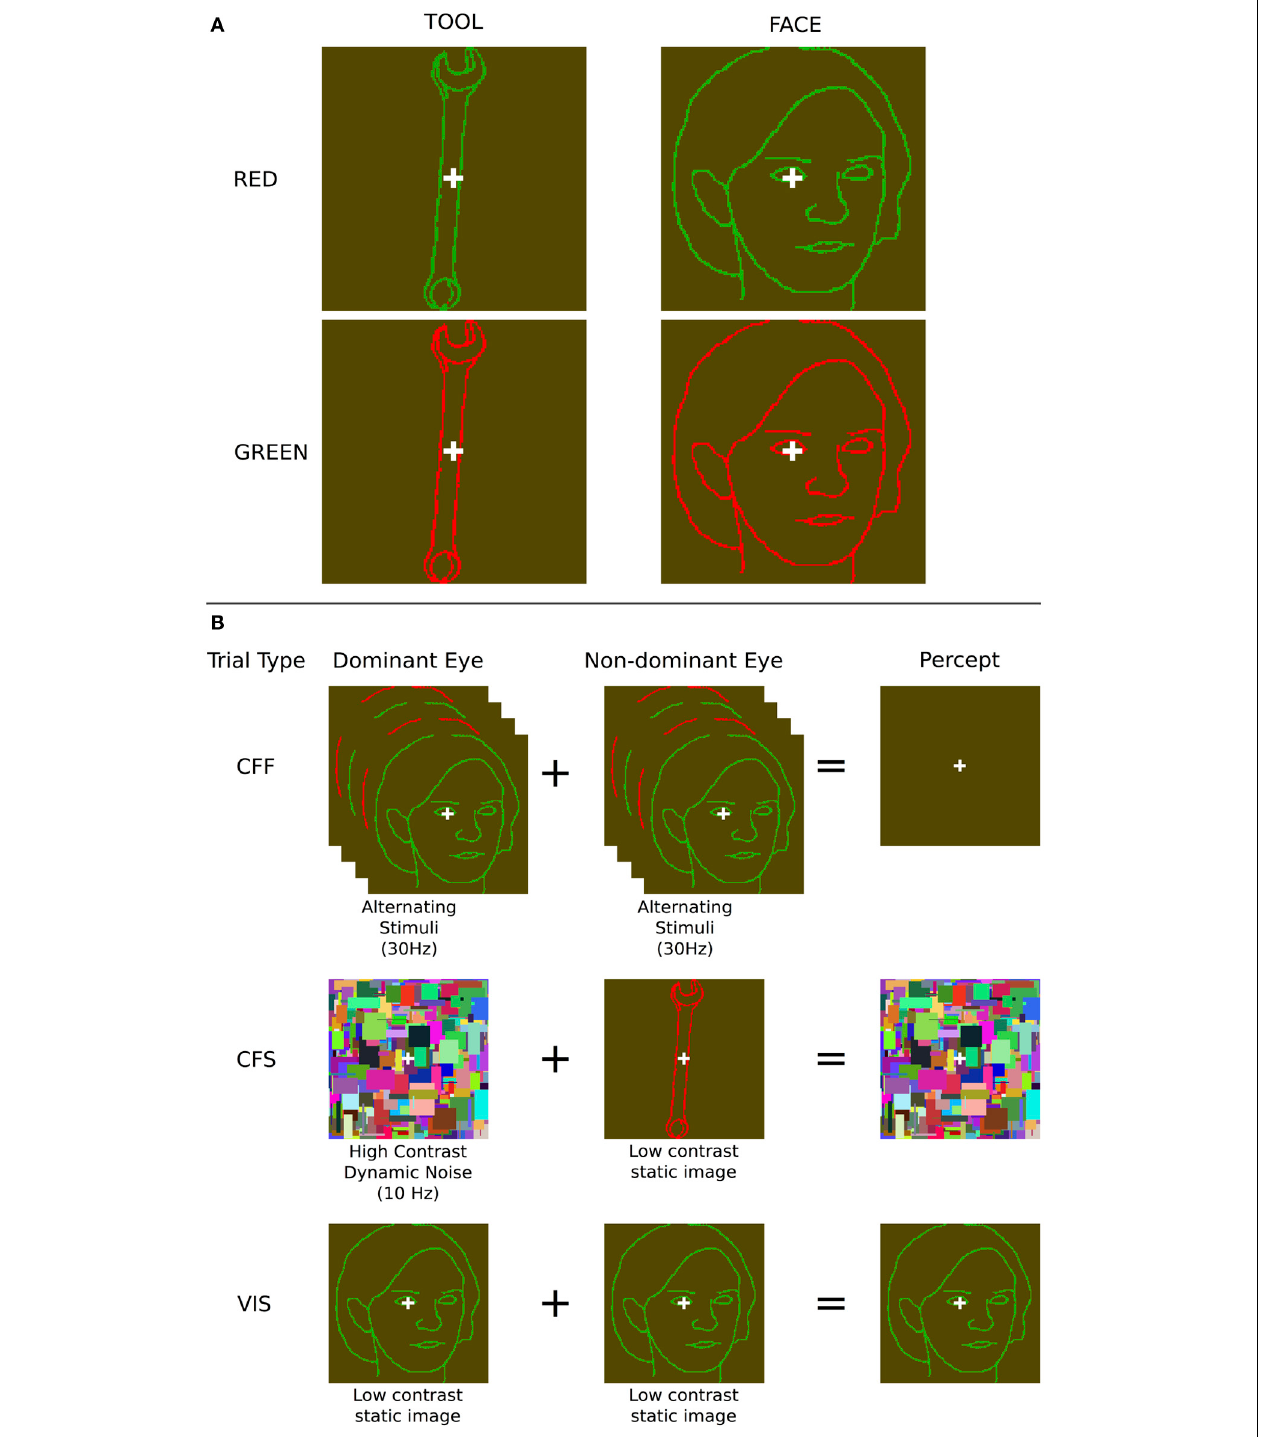
FIGURE 1 | Stimuli and presentation methods used. (A) Example face and tool stimuli—note that the contrast of the outline stimuli, which were in fact perceptually isoluminant, is enhanced here for illustration purposes. (B) The three presentation methods: During chromatic flicker fusion trials, isoluminant images were flickered in both eyes continuously at 30Hz and rendered invisible; During